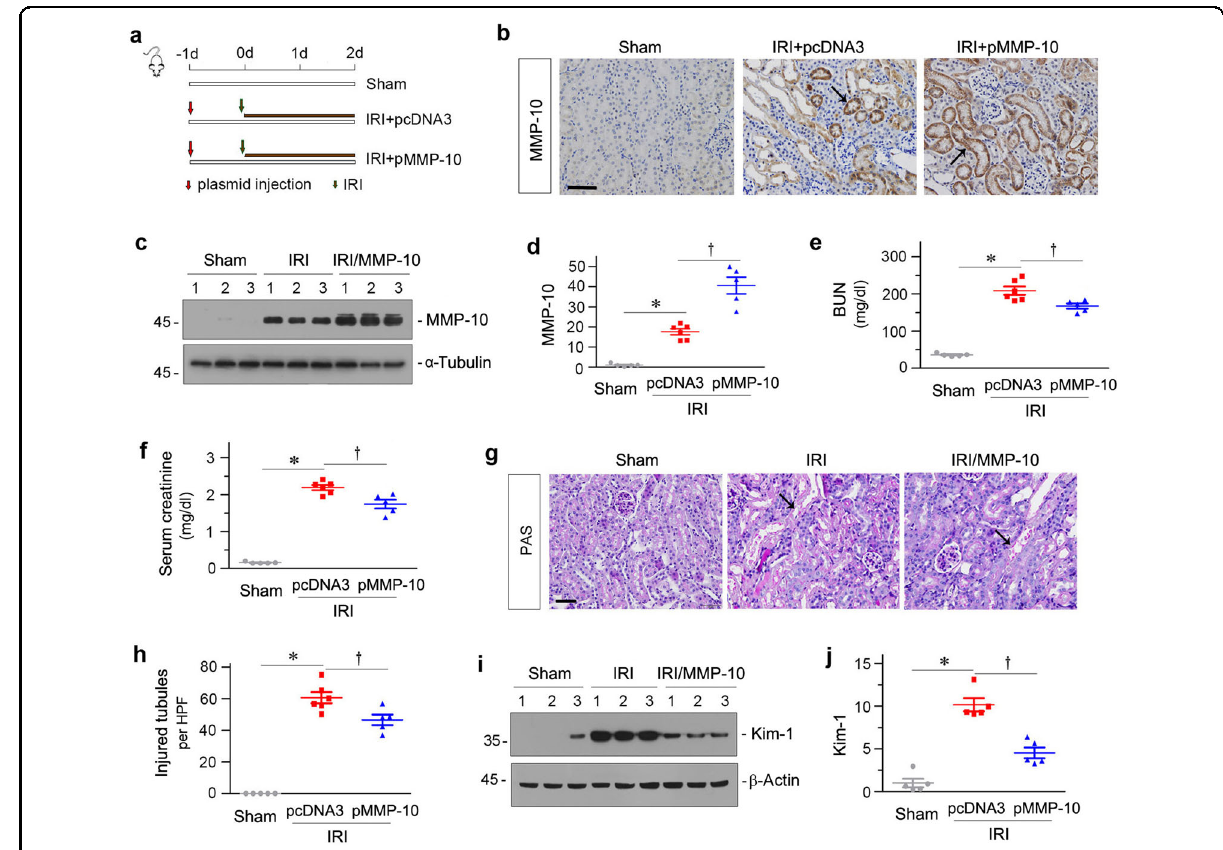
Fig. 2 Expression of exogenous MMP-10 protects mice against AKI after IRI. a Experimental design. Red arrows indicate the injection of pcDNA3 or pMMP-10 plasmids. Green arrows indicate the timing of renal IRI surgery. b Representative micrographs show renal MMP-10 protein expression in different groups, as indicated. Arrow indicates positive staining. Scale bar, 50 µm. c , d Representative Western blot ( c ) and quantitative data ( d ) show the abundances of renal MMP-10 expression protein in different groups as indicated. Numbers (1 – 3) indicate each individual animal in a given group. * P < 0.05 versus sham controls ( n = 5 – 6); † P < 0.05 versus IRI injected with pcDNA3 ( n = 5 – 6). e , f Graphic presentations show blood urea nitrogen (BUN) ( e ) and serum creatinin e ( f ) levels in different groups as indicated. * P < 0.05 versus sham controls ( n = 5 – 6); † P < 0.05 versus IRI injected with pcDNA3 ( n = 5 – 6). g Representative micrographs show kidney morphology after IRI in different groups of mice as indicated. Kidney sections were subjected to PAS staining. Kidney sections were stained with PAS reagents. Arrows indicate injured tubules. Scale bar, 50 µm. h Quantitative analyses of injured tubules in three groups as indicated. At least 10 randomly selected fi elds in the cortex-medulla junctional area were evaluated and results were averaged for each kidney. * P < 0.05 versus sham controls; † P < 0.05 versus IRI injected with pcDNA3 ( n = 5 – 6). i , j Representative western blot ( i ) and quantitative data ( j ) show renal Kim-1 expression. Numbers (1 – 3) indicate each individual animal in a given group. * P < 0.05 versus sham controls ( n = 5 – 6); † P < 0.05 versus IRI injected with pcDNA3 ( n = 5 –